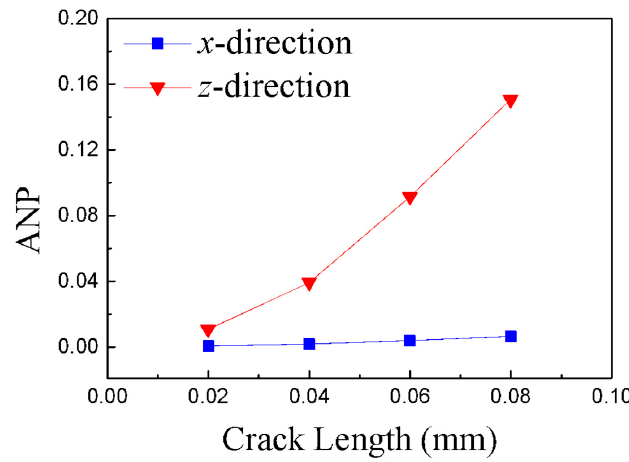
Figure 13. ANP versus crack number ( μ = 0.3).